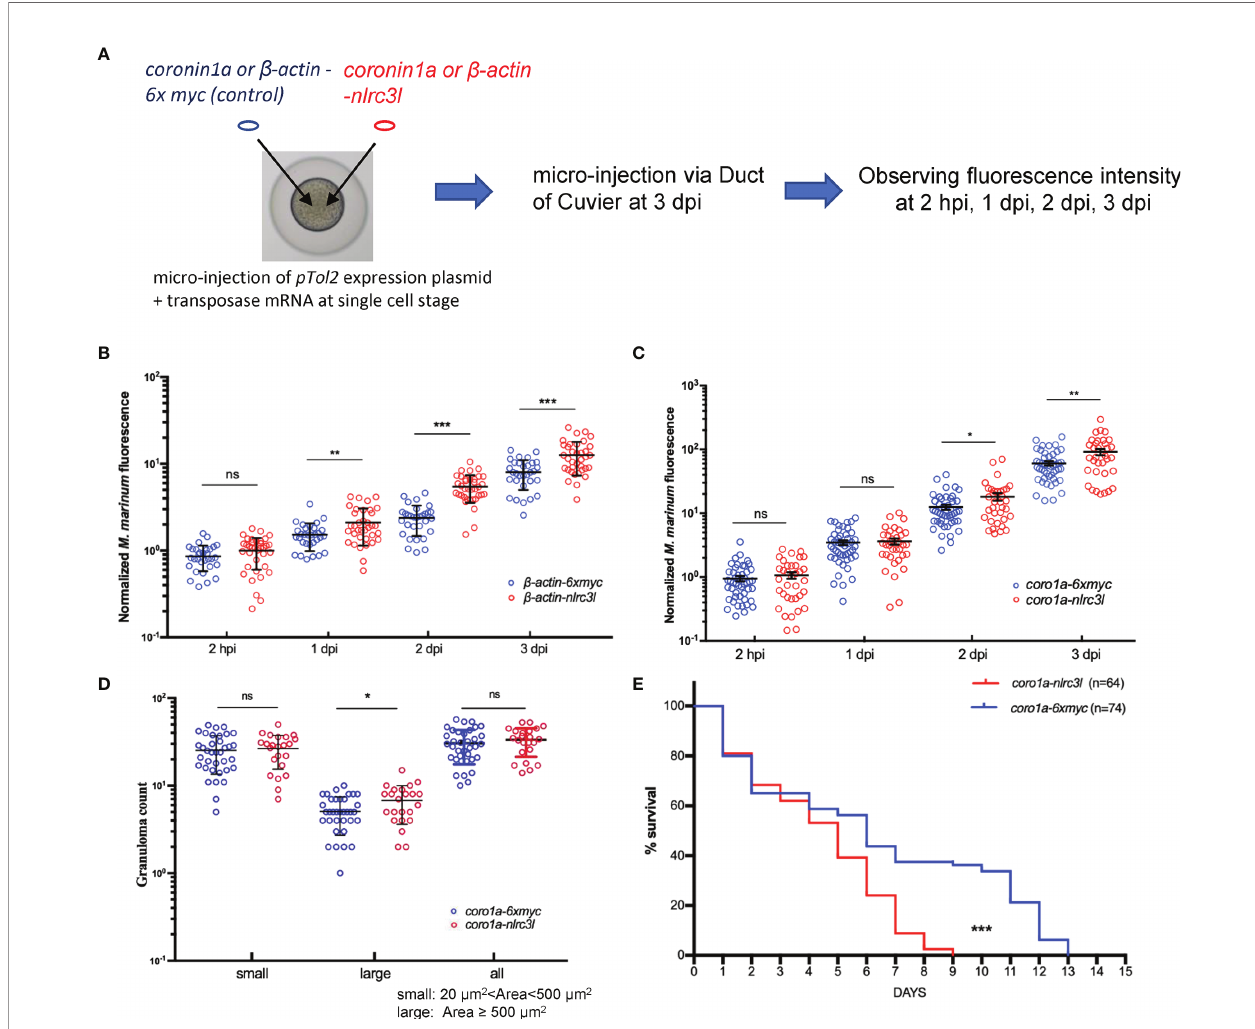
FIGURE 3 | The impact of nlrc3-like on host defense against mycobacterial infection was mainly mediated by innate immune cells. (A) Schematic view of the construction of nlrc3-like overexpressing embryos and the M. marinum infection assay. pTol2 plasmids were injected at the single-cell stage and subsequently the grown embryos were infected via the duct of Cuvier at 3 dpf. Injections of pTol2- b -actin-nlrc3-like ( b -actin-nlrc3l ) and pTol2-coronin1a-nlrc3-like ( coro1a- nlrc3l ) generated embryos overexpressing nlrc3-like in all cells or only in myeloid cells, respectively. Black arrows indicate injection sites. (B) Graph of the relative green fl uorescence intensity of the b -actin-nlrc3l group and the b -actin-6xmyc group at the indicated time points. (C) Graph of the relative green fl uorescence intensity of the coro1a-nlrc3l and coro1a-6xmyc embryos at the indicated time points. (D) Graph showing the number of granuloma-like structures in the coro1a-nlrc3l and the coro1a-6xmyc embryos. (E) Survival curve of coro1a-nlrc3l and coro1a-6xmyc embryos. The data shown represents the averages from two independent biological replicates *p ≤ 0.05; **p ≤ 0.01; ***p ≤ 0.001; ns, not statistically signi fi cant